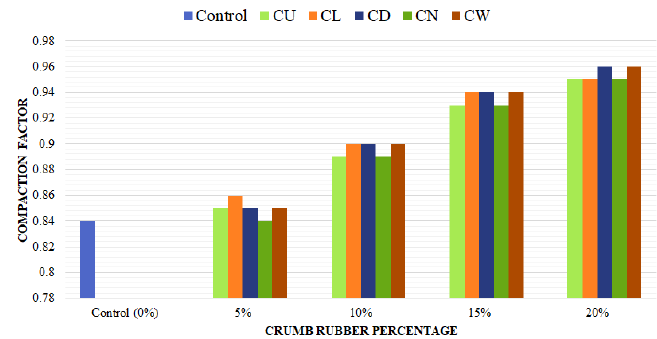
Figure 2. Compaction factor results.